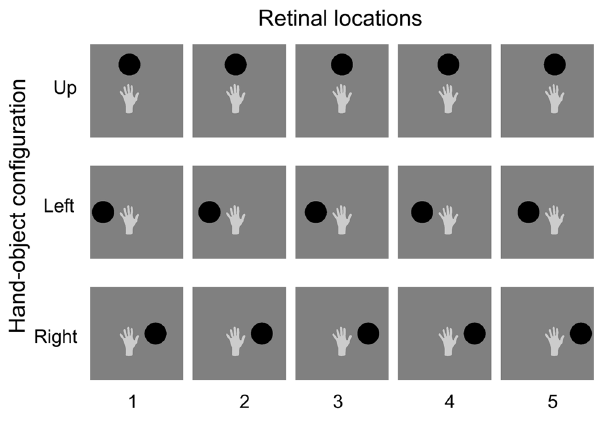
Figure 1. Image sequences. The three image sequences presented to VisNet during training are shown in the separate rows. All of the images in each sequence consist of a hand and a circular visual object. For each image sequence, the visual object is fixed in one of three possible positions with respect to the hand. Top row: visual object is shown in the ‘Up’ location with respect to the hand. Middle row: visual object is shown in the ‘Left’ location with respect to the hand. Bottom row: visual object is shown in the ‘Right’ location with respect to the hand. Each of the three image sequences arises from a series eye movements that result in small shifts in the position of the hand and visual object on the retina (e.g. drifts or microsaccades). The relative positions of the hand and object are unchanged by these micro- saccades. During each of the three image sequences, the fixed spatial configuration of the hand and object is translated five pixels at a time towards the right across columns 1 to 5.